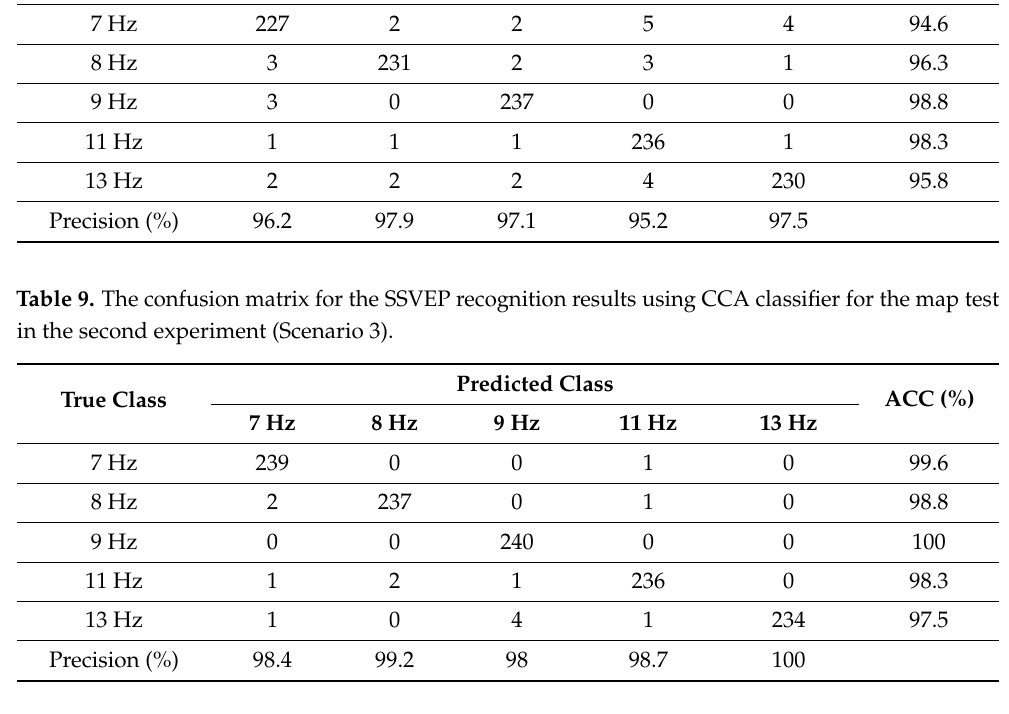
Table 10. The confusion matrix for the SSVEP recognition results using MSI classifier for the direction test in the second experiment (Scenario 1).